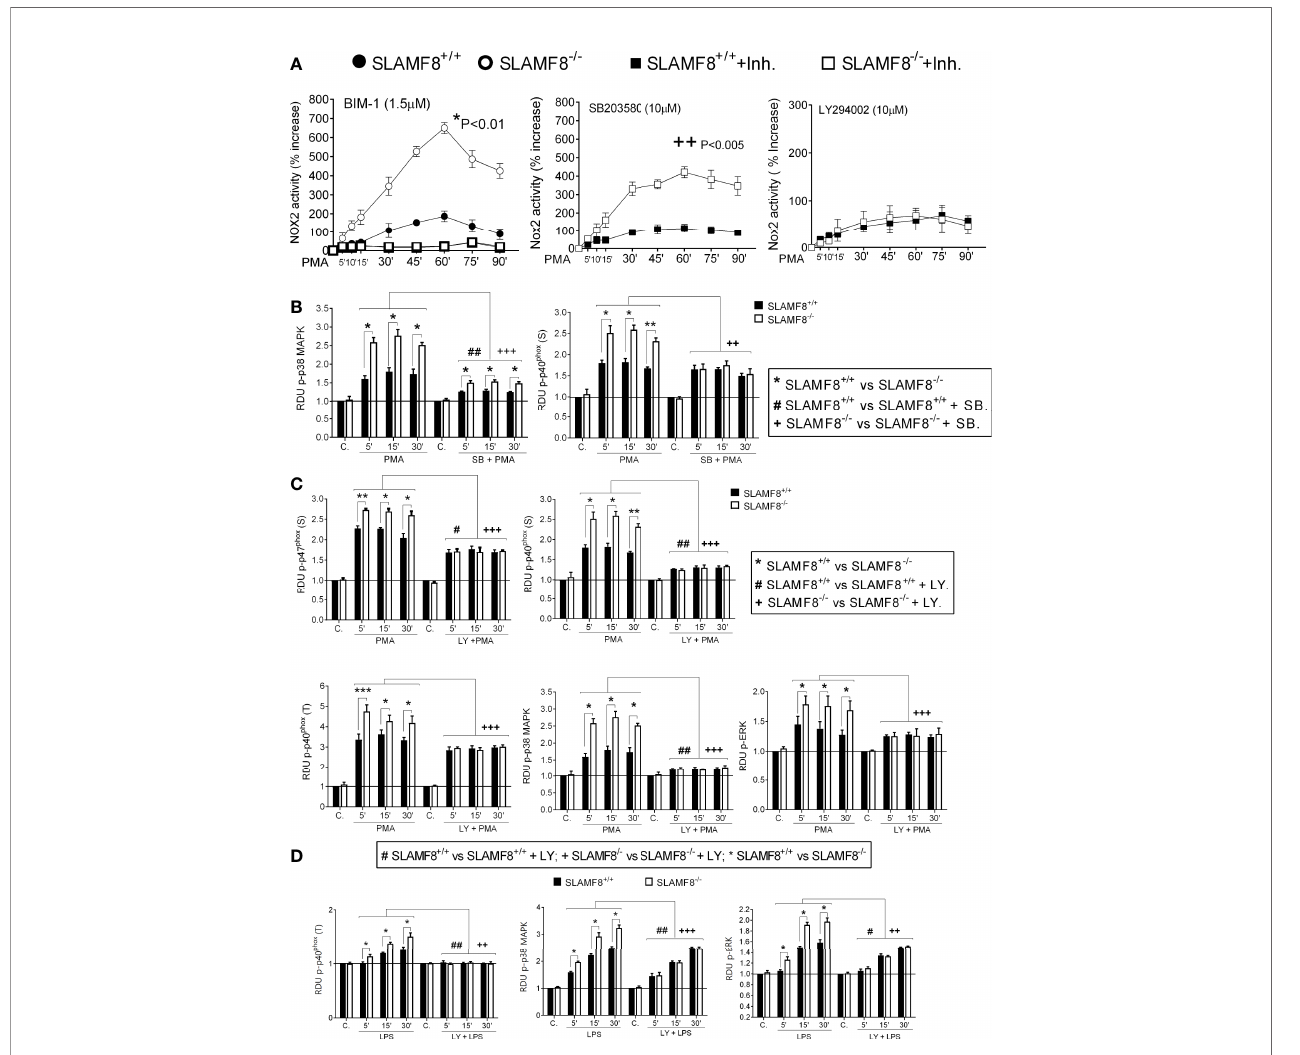
FIGURE 4 | Study of ROS production and activation of NOX2 subunits in SLAMF8 +/+ and SLAMF8 -/- pMø pretreated with inhibitors and stimulated with PMA or LPS. pMø were pretreated with or without 5 µM bisindolylmaleimide I (BIM1), 10 µM SB203580 (SB), or 10 µM LY294002 (Ly) for 1 h, and stimulated with 100 ng/ml PMA (B, C) or 10 µg/ml LPS (C) at different time points. (A) Analysis of ROS production monitored through lucigenin-luminescence assay, calculated as percentage increase over t 0 . Values indicate mean ± SEM. * Differences between SLAMF8 +/+ pMø vs. SLAMF8 -/- pMø; + Differences between SLAMF8 +/+ vs. SLAMF8 -/- samples treated with the indicated inhibitor. (B – D) The graphs show the relative expression levels of the indicated proteins, as analyzed by Western blotting ( Figures S2 , S3 ), in pMø stimulated with PMA (B, C) or LPS (D) . Levels were normalized to appropriate loading controls and are graphically represented. *Indicates differences between SLAMF8 +/+ pMø vs. SLAMF8 -/- pMø at each time point, * p < 0.05; ** p < 0.01; *** p < 0.001; # indicates differences between SLAMF8 +/+ pMø vs. SLAMF8 +/+ pMø treated with inhibitors. # p < 0.05; ## p < 0.01; + indicates differences between SLAMF8 -/- pMø vs. SLAMF8 -/- pMø treated with inhibitors, ++ p < 0.01; +++ p < 0.001. Values indicate mean ± SEM of three independent experiments. C, Control; RDU, relative densitometry units; S, Serine; T,